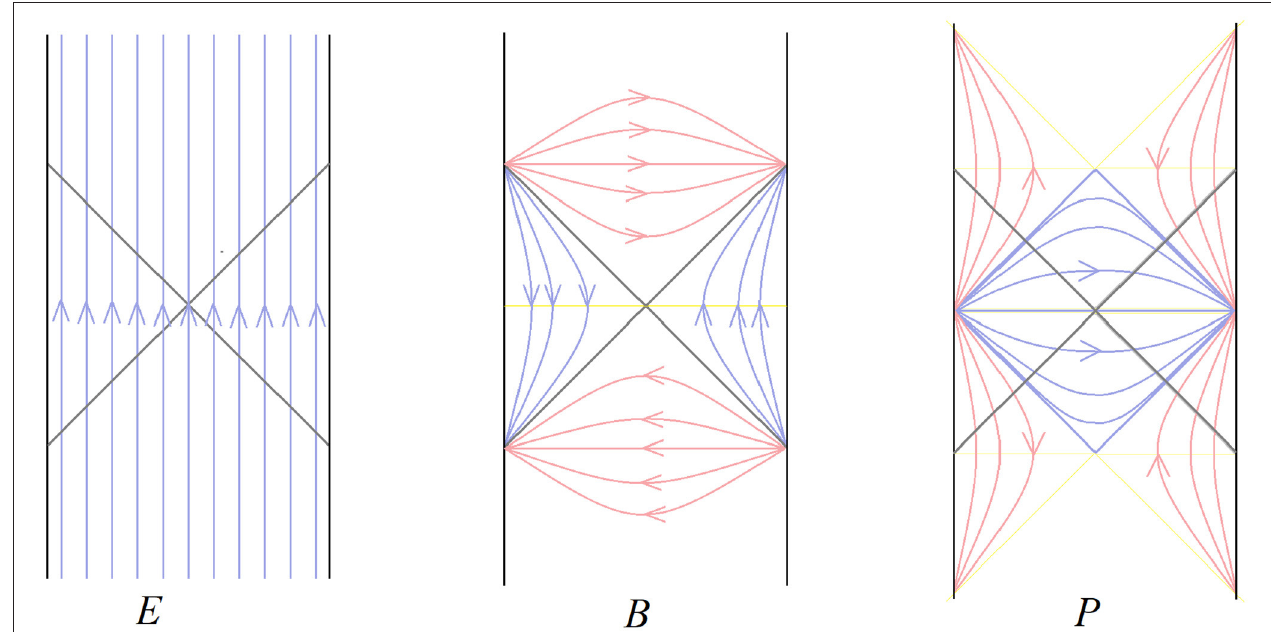
FIGURE 8 | Orbits of the three